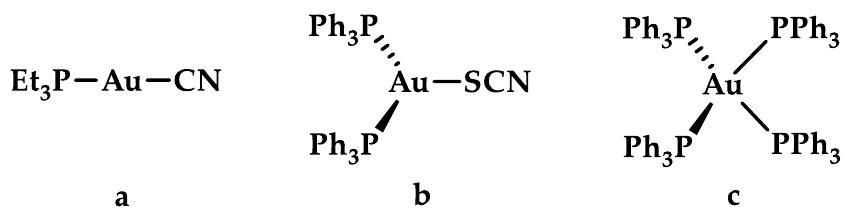
Figure 2. Different coordination geometries of Au(I) complexes with coordination number ( a ) 2, linear; ( b ) 3, trigonal planar; and ( c ) 4, tetrahedral.